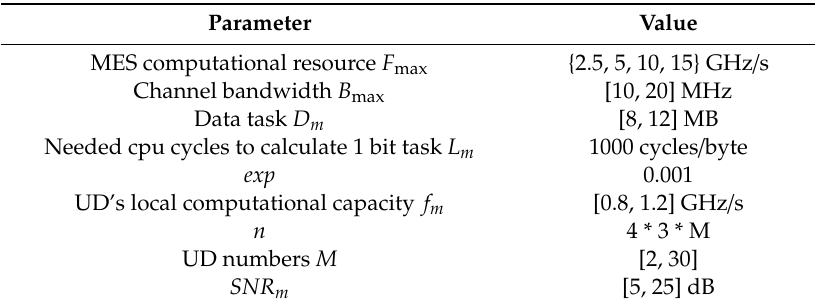
Table 1. Simulation parameters.